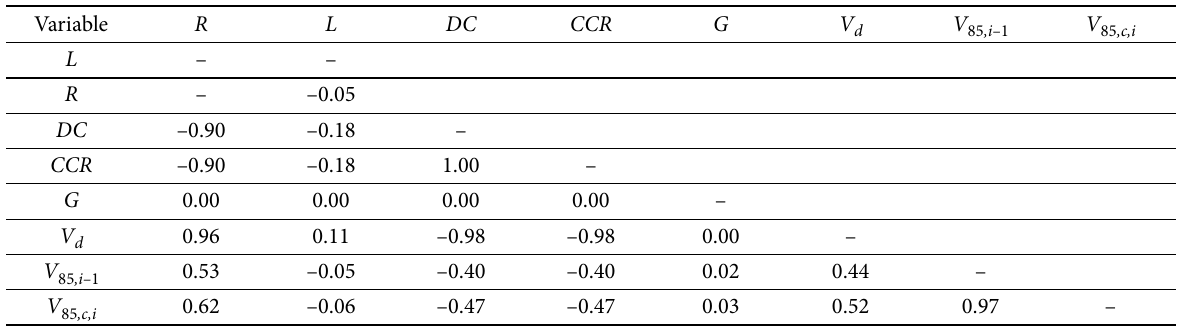
Table 3. Correlation matrix for geometric characteristics, design speed and operating speed for curvilinear elements ( n = 20) Variable